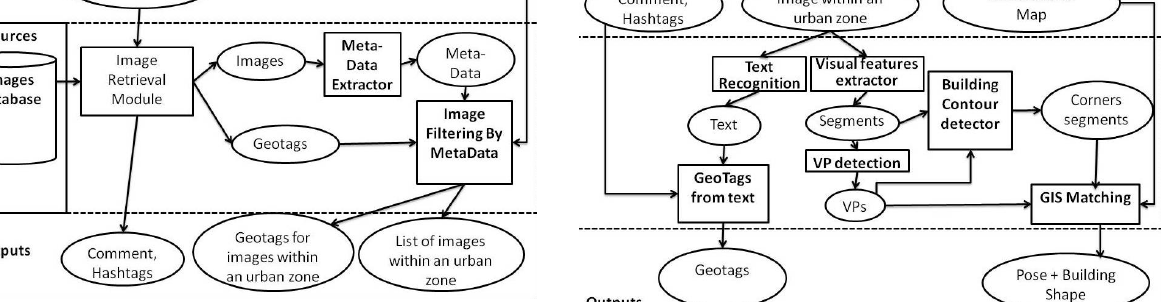
Figure 3. Features extraction layer.